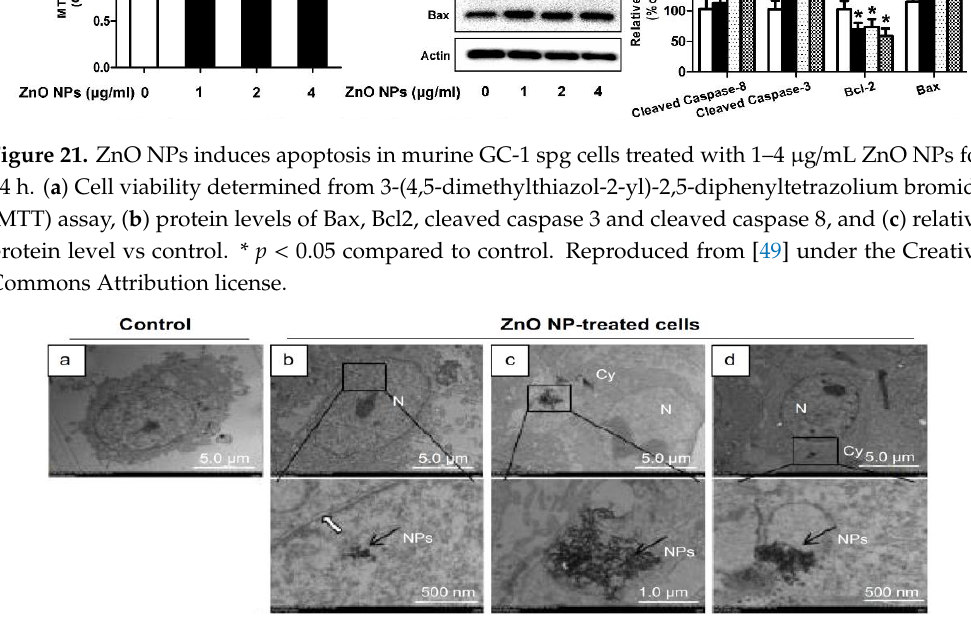
Figure 22. Transmission electron microscopic images showing ( a ) untreated Leydic cell (control), and ( b – d ) localization of ZnO NPs within the nucleus (N) and cytoplasm (Cy) of the cell. Bottom panel: high magnification views of the framed region. Reproduced from [143] with under the Creative Commons Attribution—Non Commercial (unported, v3.0) license.